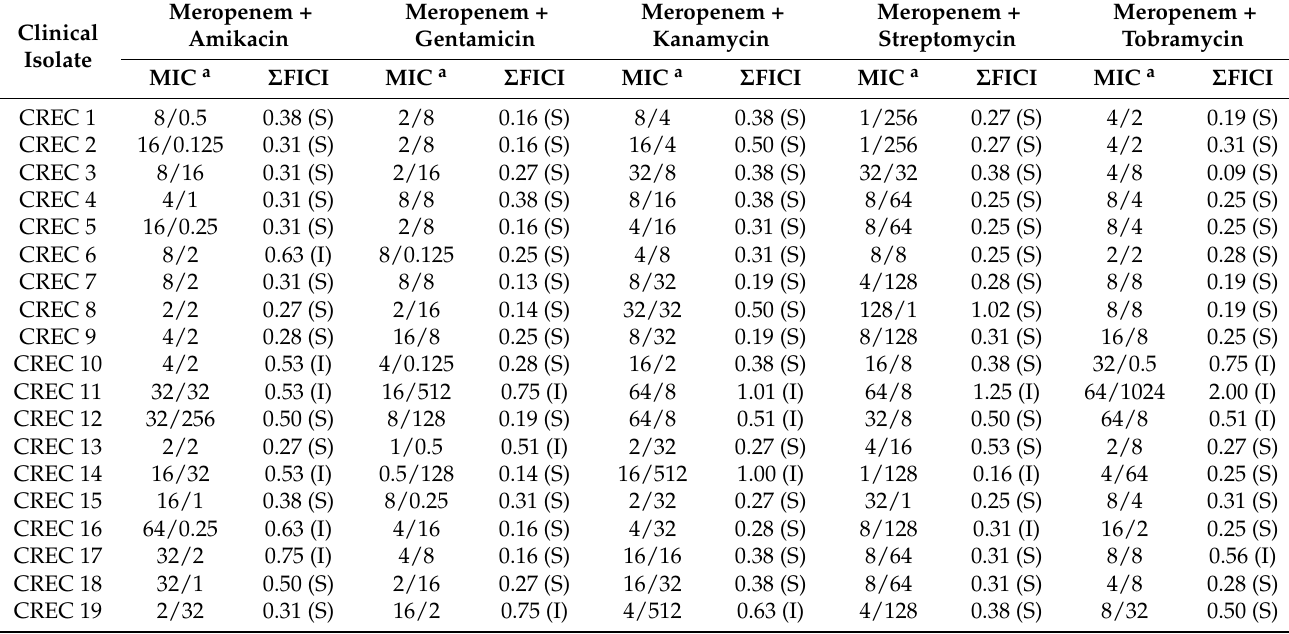
Table 4. Effects of meropenem and aminoglycosides combinations on 19 carbapenem-resistant Escherichia coli